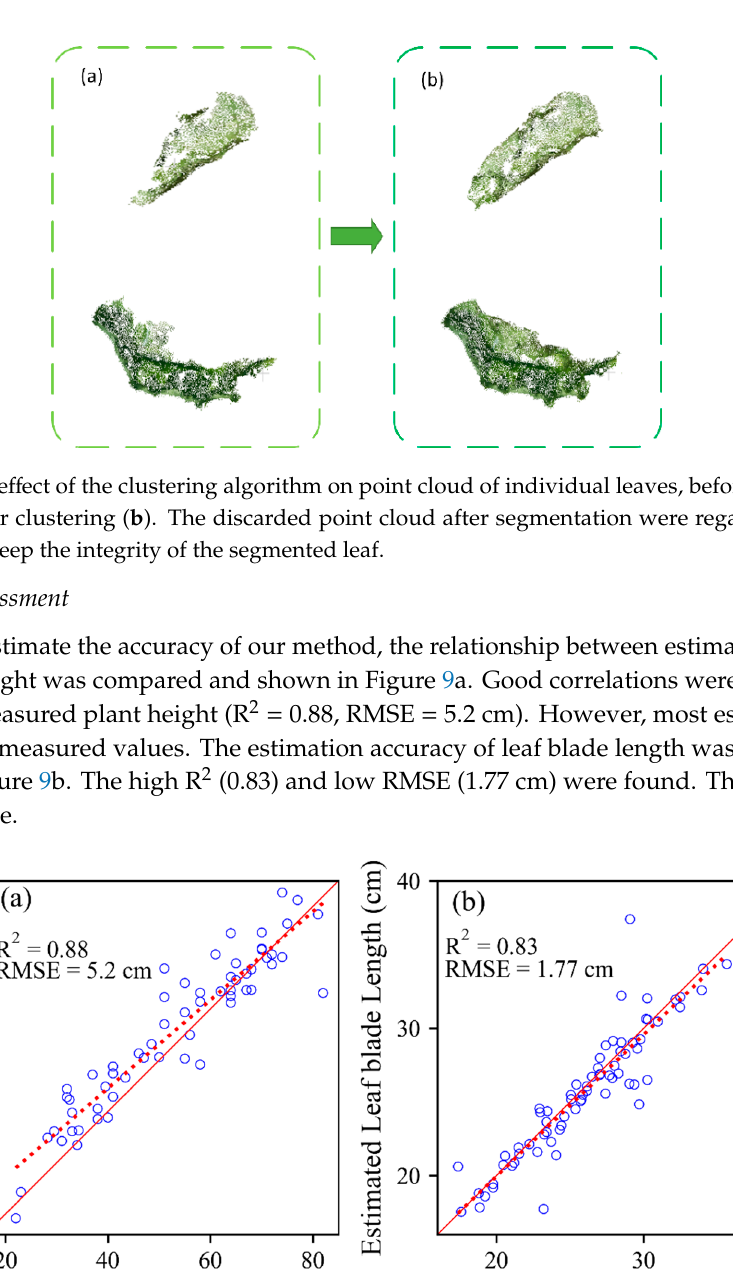
in red circle were the curved leaves which lost many points after segmentation. Leaves in blue circle were